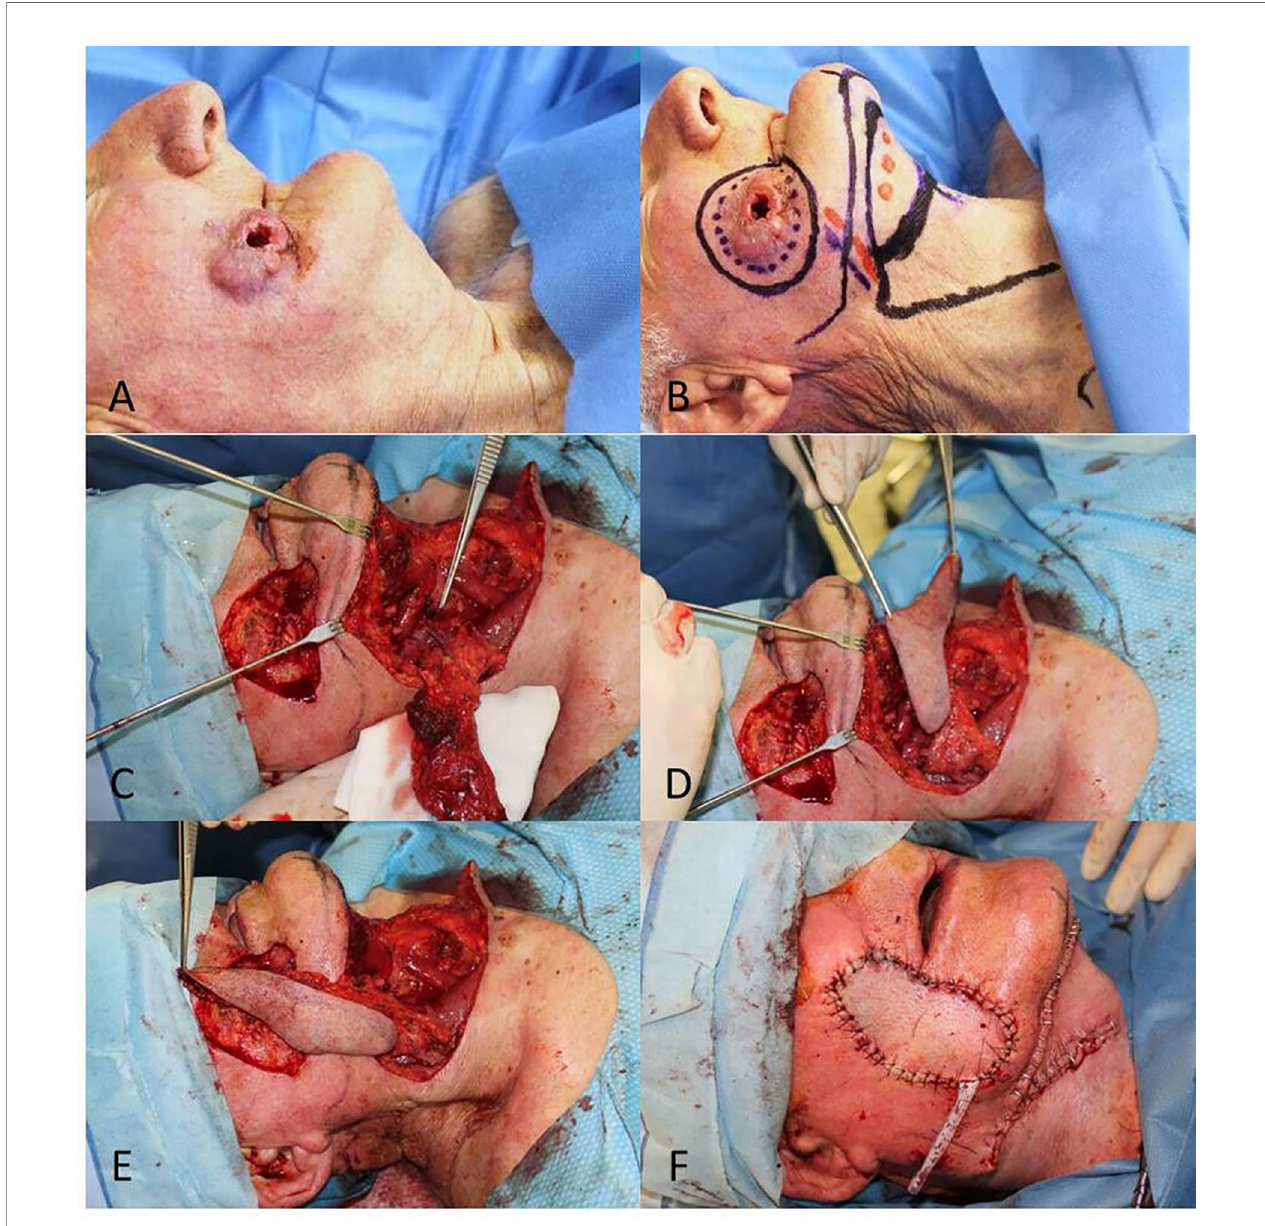
FIGURE 6 | (A) Locally advanced SCC of the cheek; (B) Planning of the full-thickness excision and the submental fl ap; (C, D) Excision complete and dissection of the fl ap based on the submental vessels; (E) Advancement of the fl ap to the defect; (F) Final